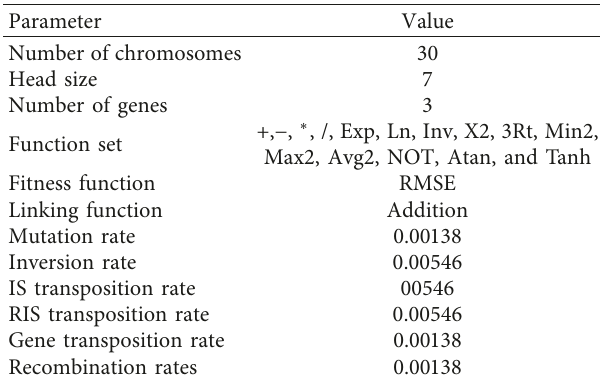
Figure 4: Variation of mean wind speed and temperature. Table 2: Parameters used in developing the GEP